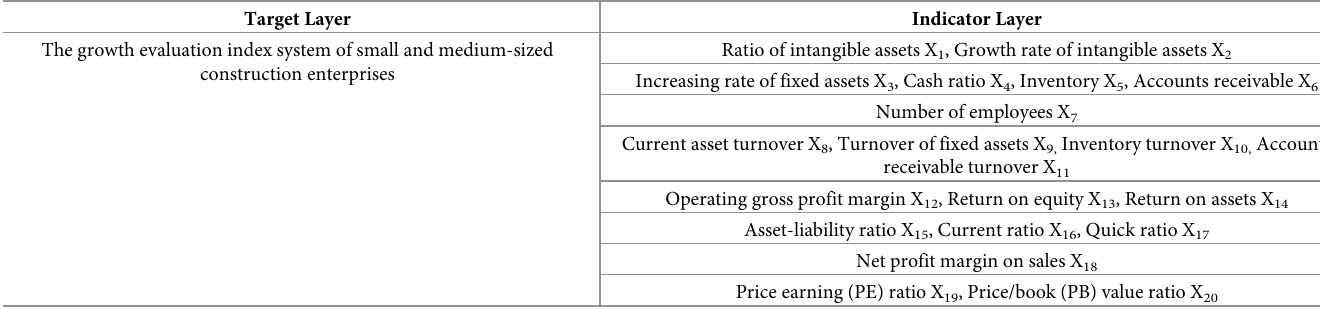
Table 1. The growth evaluation index system of small and medium-sized construction